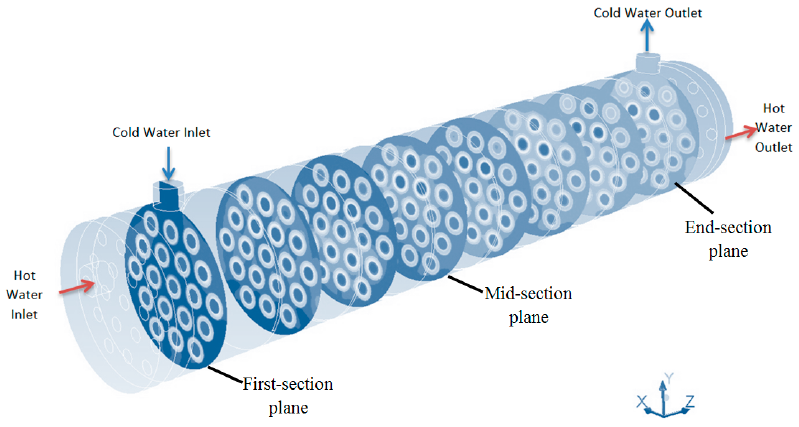
Figure 8. Schematic view of section planes defined for comparative results for shell side.